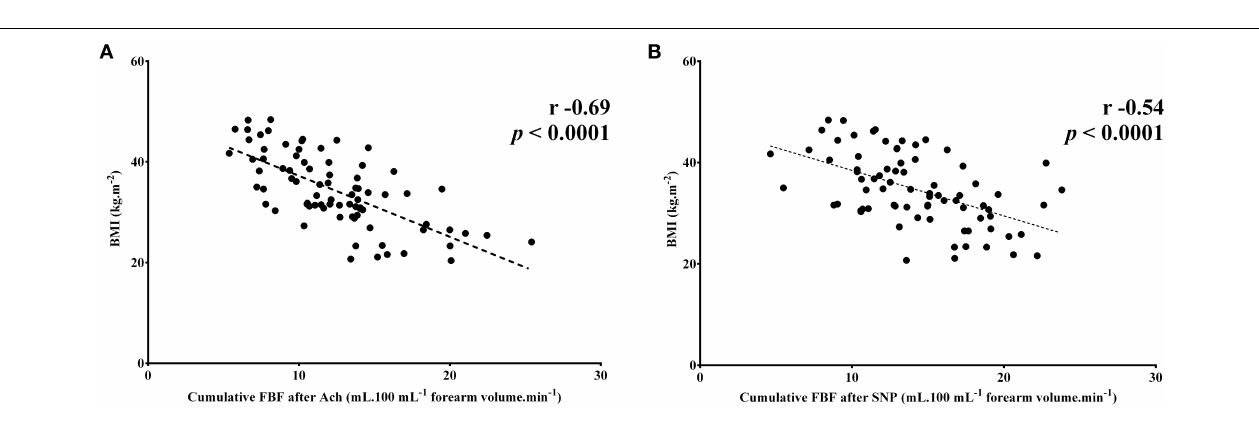
FIGURE 2 | Scatter plots of significant correlations between cumulative forearm blood flow (FBF) responses to intra-arterial infusion of vasodilators and body mass index (BMI). (A,B) Note that the